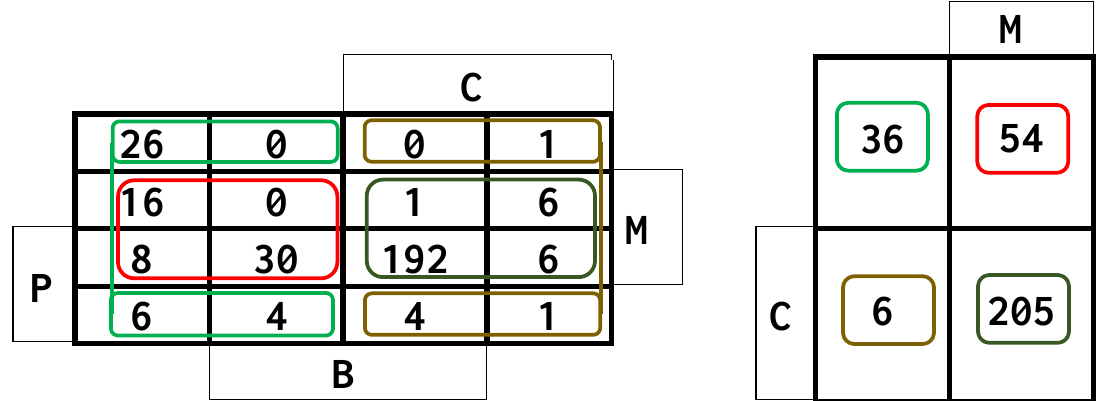
Fig. 5. Map additive elimination of 𝑁 ( 𝐶 , 𝐵 , 𝑃, 𝑀) with respect to 𝐵 and 𝑃 to obtain the contingency table of 𝐶 with respect to 𝑀